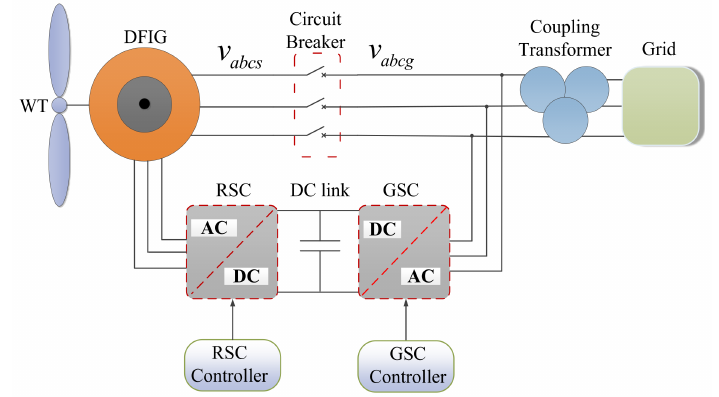
Figure 1. Basic arrangement of a grid-connected DFIG-based